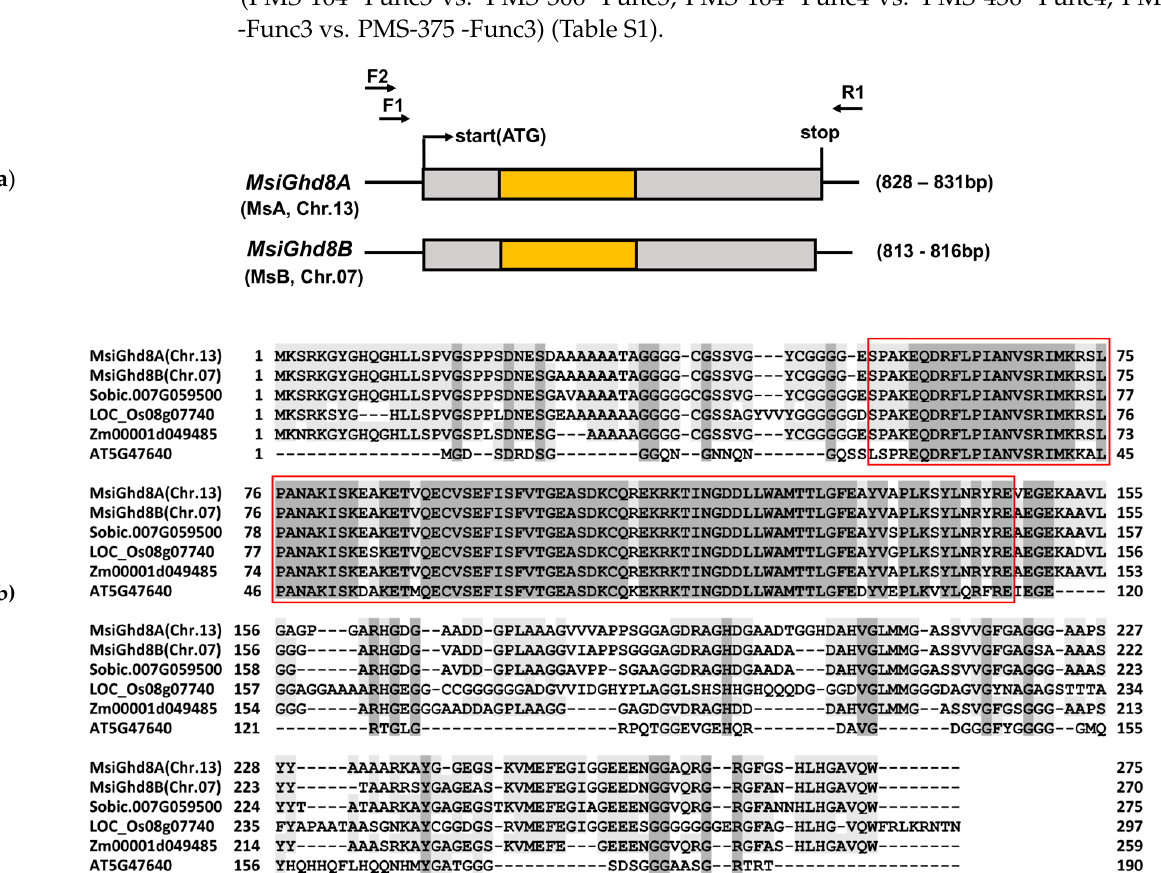
Figure 1. Gene structure and multiple alignment analysis of Miscanthus sinensis Ghd8 homoeologs and their comparison with orthologs from four other plant species. ( a ) Gene structure of MsiGhd8A and MsiGhd8B. F, forward primer; R, reverse primer; the primer pairs F1/R1 and/or F2/R1 were used to detect open reading frames (ORFs) for Ghd8 . The start codon (ATG) and stop codon (TGA) are highlighted in black. The yellow box represents the HAP3/NF-YB domain. ( b ) Multiple amino acid sequence alignments for Ghd8 from M. sinensis (this study), Sorghum bicolor (Sobic.007g059500), Oryza sativa (LOC_Os08g07740), Zea mays (Zm0001d049485) and Arabidopsis thaliana (AT5G47640). The HAP3/NF-YB domain is boxed in red. The M. sinensis sequence used for alignment was from accession